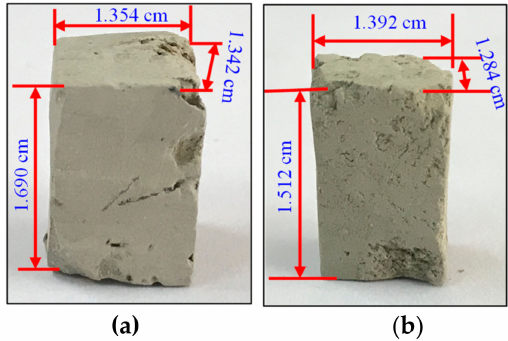
Figure 1. Sediments samples after drying: ( a ) ZN1-2 and ( b ) LK1-2.